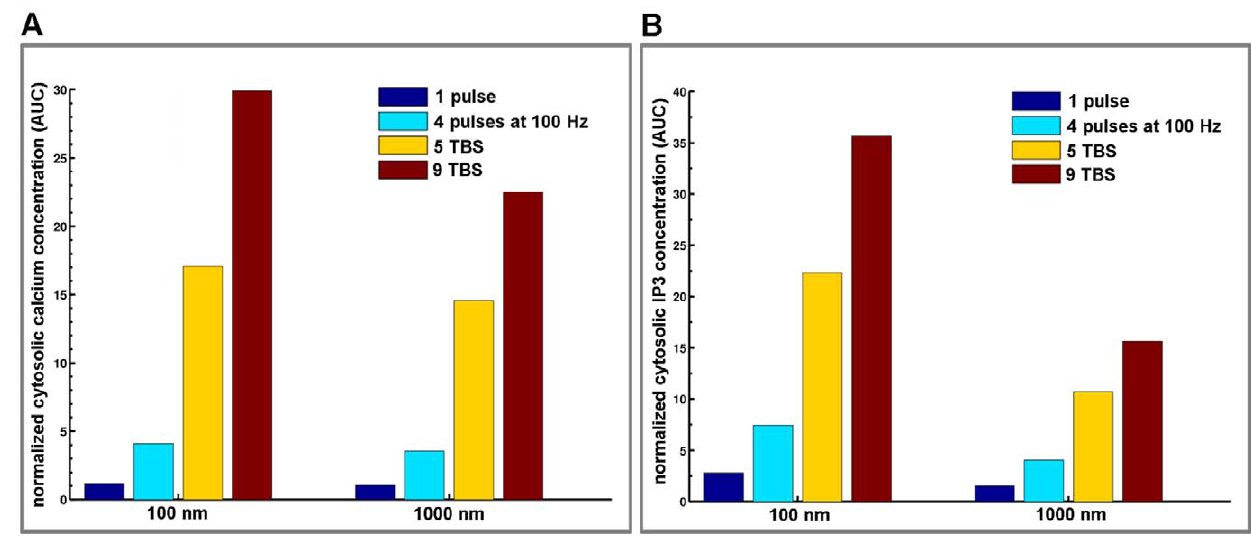
Figure 8. Effects of stimulation pattern and mGluRI location on integrated changes in calcium and IP3 concentration. (A) Histograms represent the quantification of the AUC for glutamate-mediated calcium dynamics with various stimulation patterns and mGluRI located at 100 nm and 100 nm from the release site. (B) Corresponding histograms of the AUC for glutamate-mediated IP3 dynamics with various stimulation patterns and mGluRI located at 100 nm and 1000 nm from the release site. AUC values were normalized to the AUC value calculated for one release event with mGluRI located at 1000 nm from the release site.